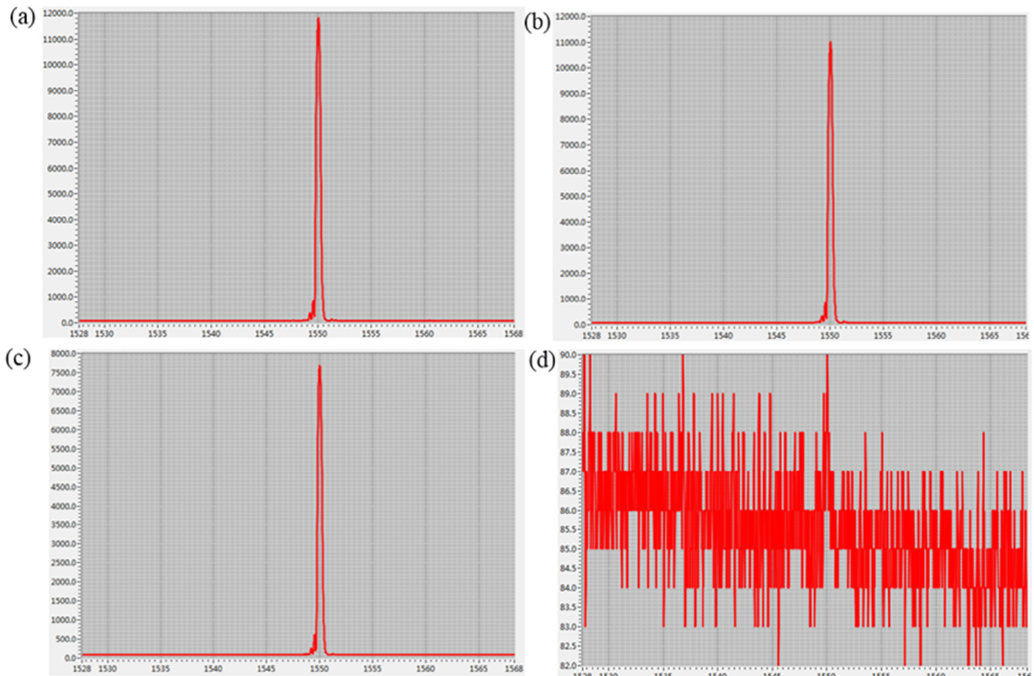
Figure 8. The relationship between fiber bending and the AD value fluctuate of the FBG reflected wavelength. ( a ) The optical fiber is freely extended, ( b ) the bending radius is 12.5 mm, ( c ) the bending radius is 10 mm, and ( d ) the bending radius is 7.5 mm.